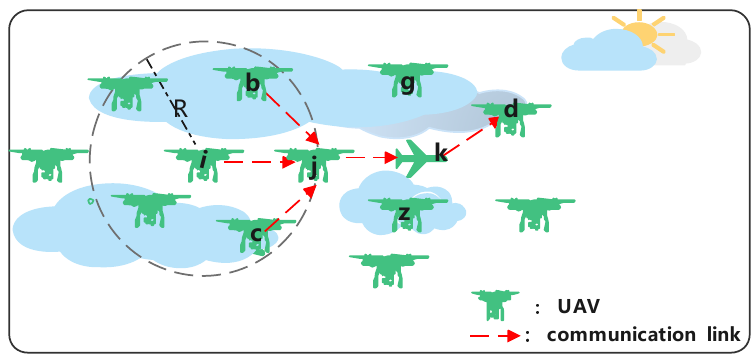
Figure 1. UAV network topology and communication